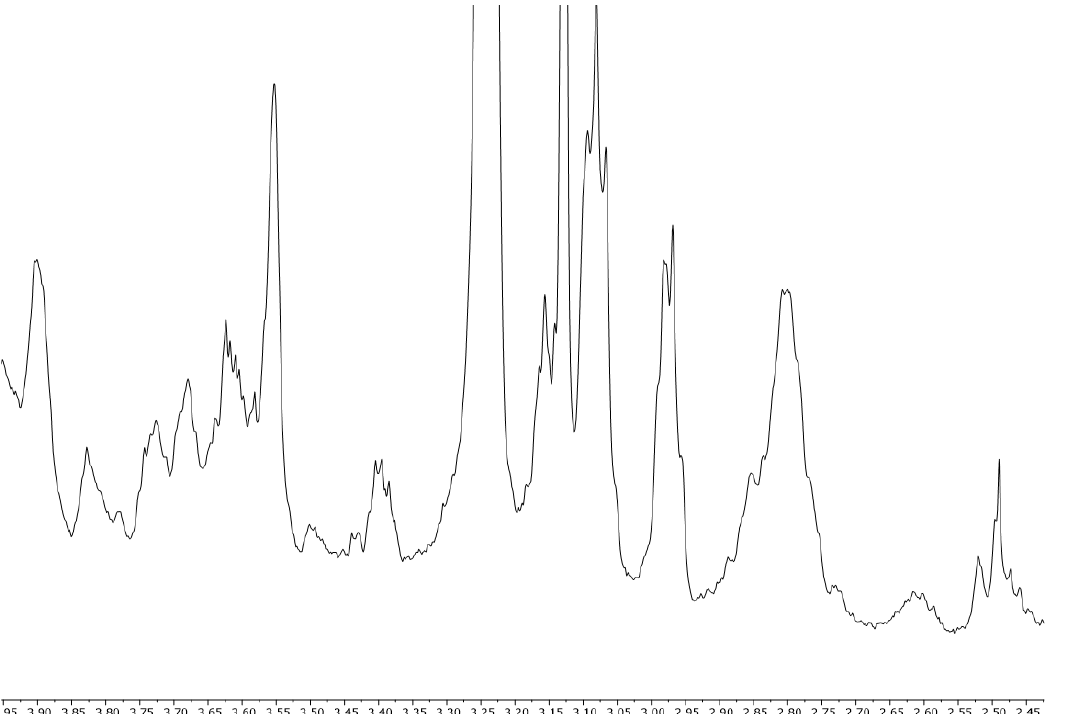
Figure 8. Expanded region B (δ = 2.45 –3.95 ppm) of a 1 H-NMR spectra (500 MHz, CD 3 OD) of Vespa velutina venom obtained by electrical stimulation.